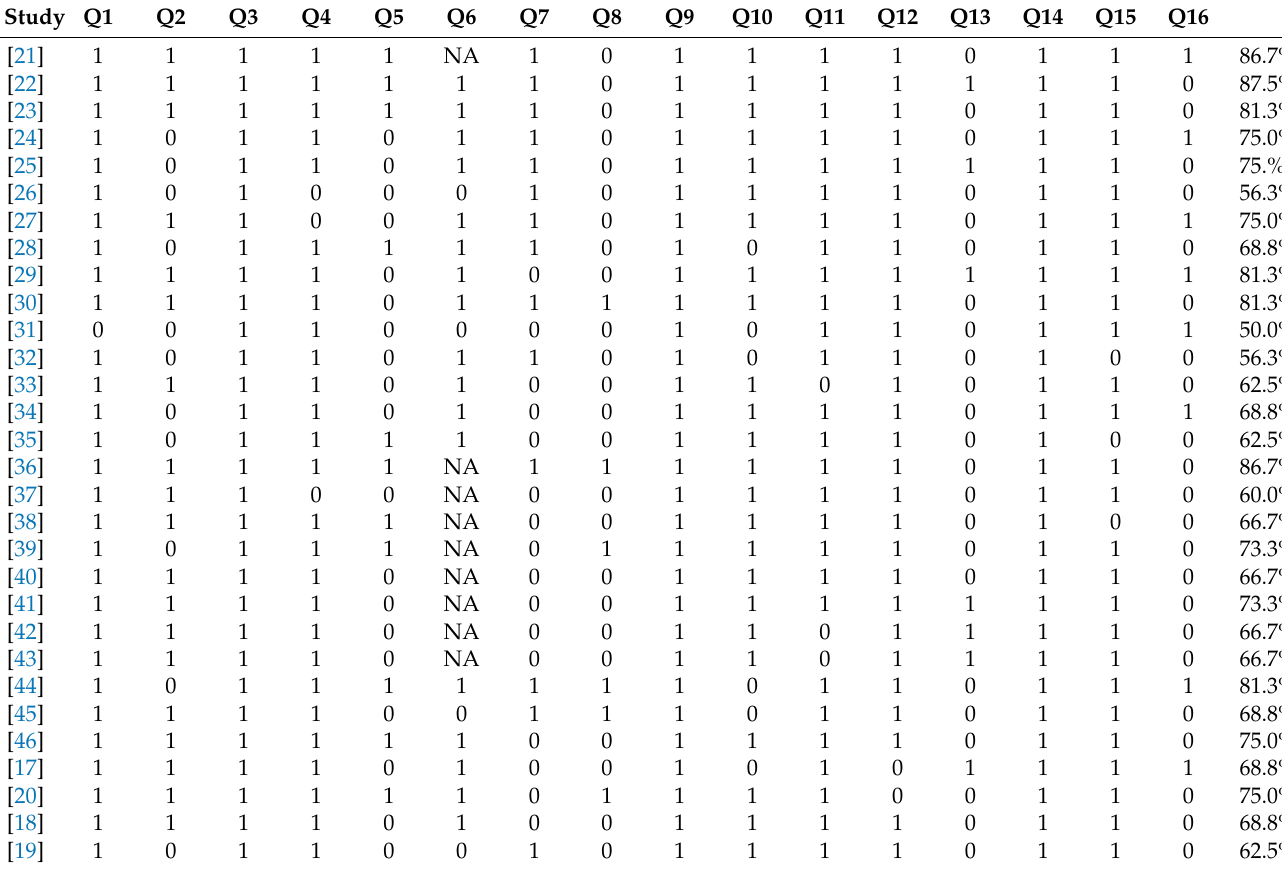
Table 1. Assessment of quantitative studies quality.